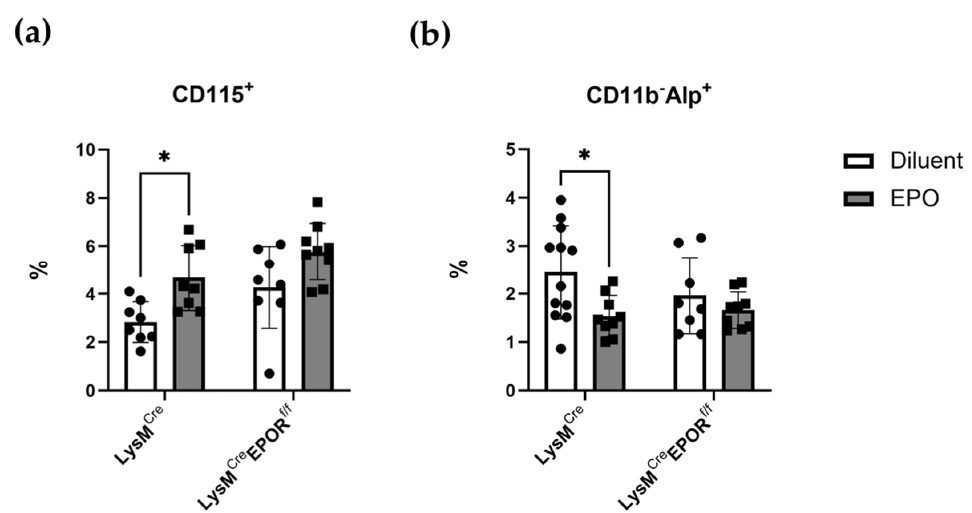
Figure 7. In vivo effects of monocytic EPOR knockout on bone cell precursors. Flow cytometry analysis of ( a ) preosteoclasts (CD115 + ) and ( b ) preosteoblasts (CD11b − Alp + ) from the bone marrow of female LysM Cre EPOR f/f mice and their controls after treatment with either diluent or EPO. n = 8–12 in each group. * p < 0.05 versus diluent. All data are mean ± SEM. p values were calculated by 2-way ANOVA.